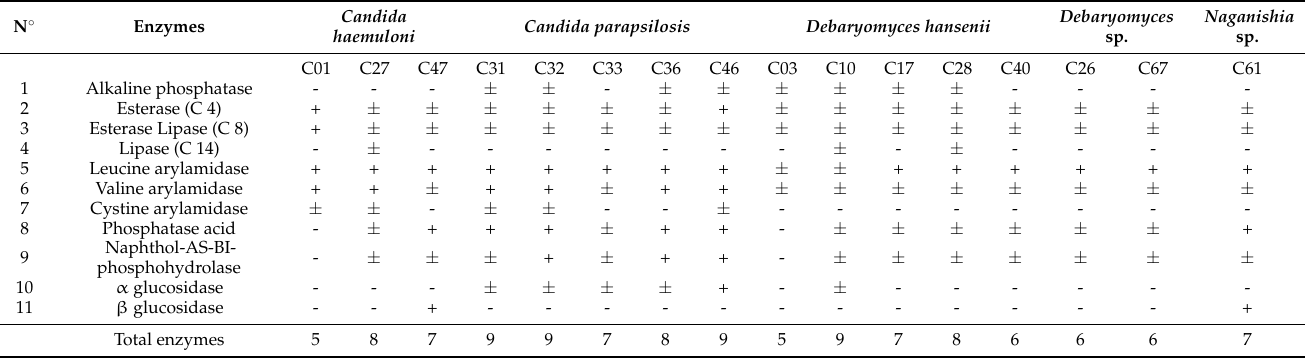
Table 3. Enzymatic activity of the 16 yeast strains determined using the API-ZYM colorimetric test.